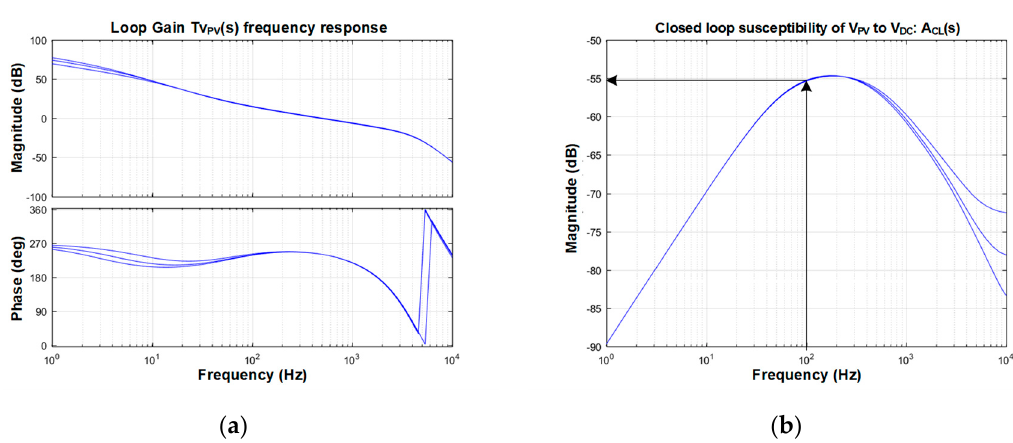
Figure 7. V PV control loop.